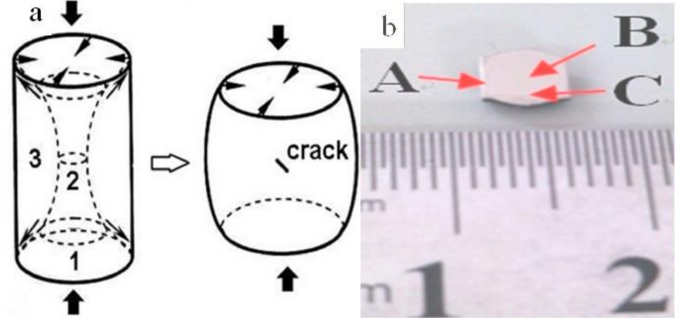
Figure 11. Stress states of different parts in the compressive sample: ( a ) schematic diagram; ( b ) actual